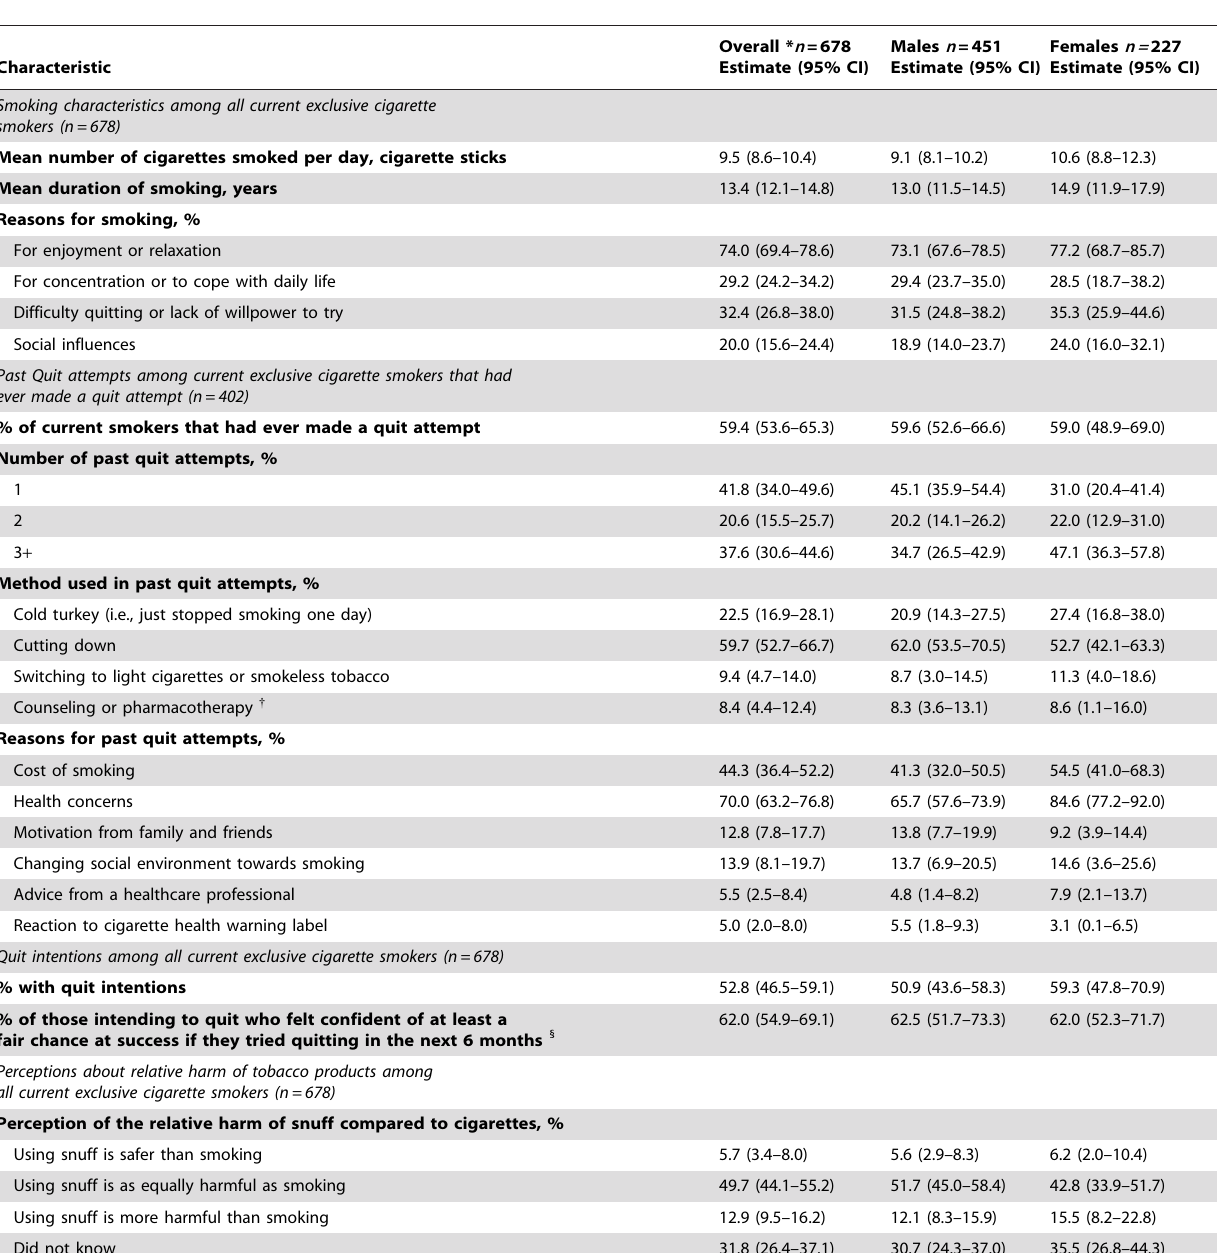
Table 2. Tobacco use, quit attempts and perceptions of current exclusive cigarette smokers, South African Social Attitudes Survey,